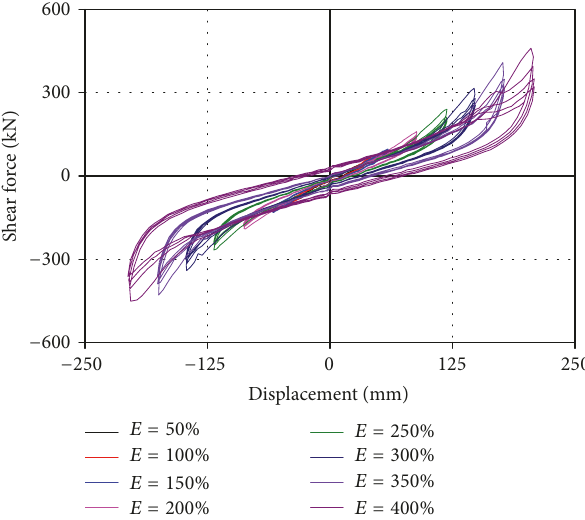
Figure 5: The hysteresis curves of the laminated rubber bearing